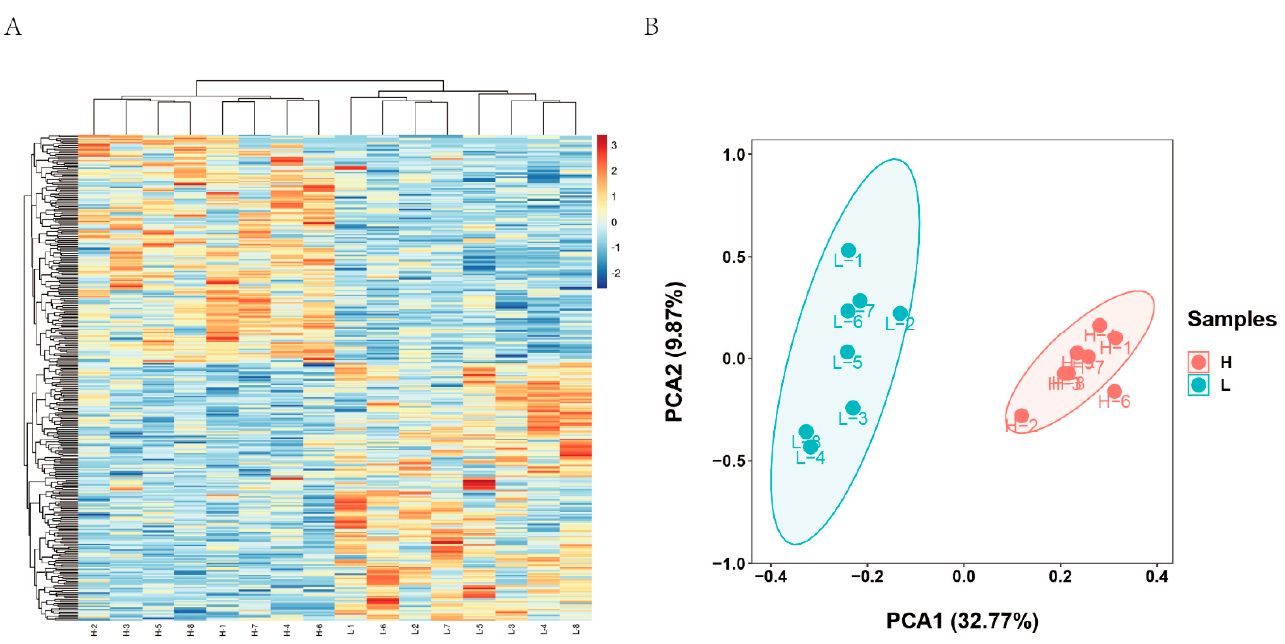
Figure 4. Expression profiles analysis of DEGs. ( A ) Heat map of DEGs between H (high) and L (low) groups. ( B ) PCA of DEGs between H (high) and L (low) groups.